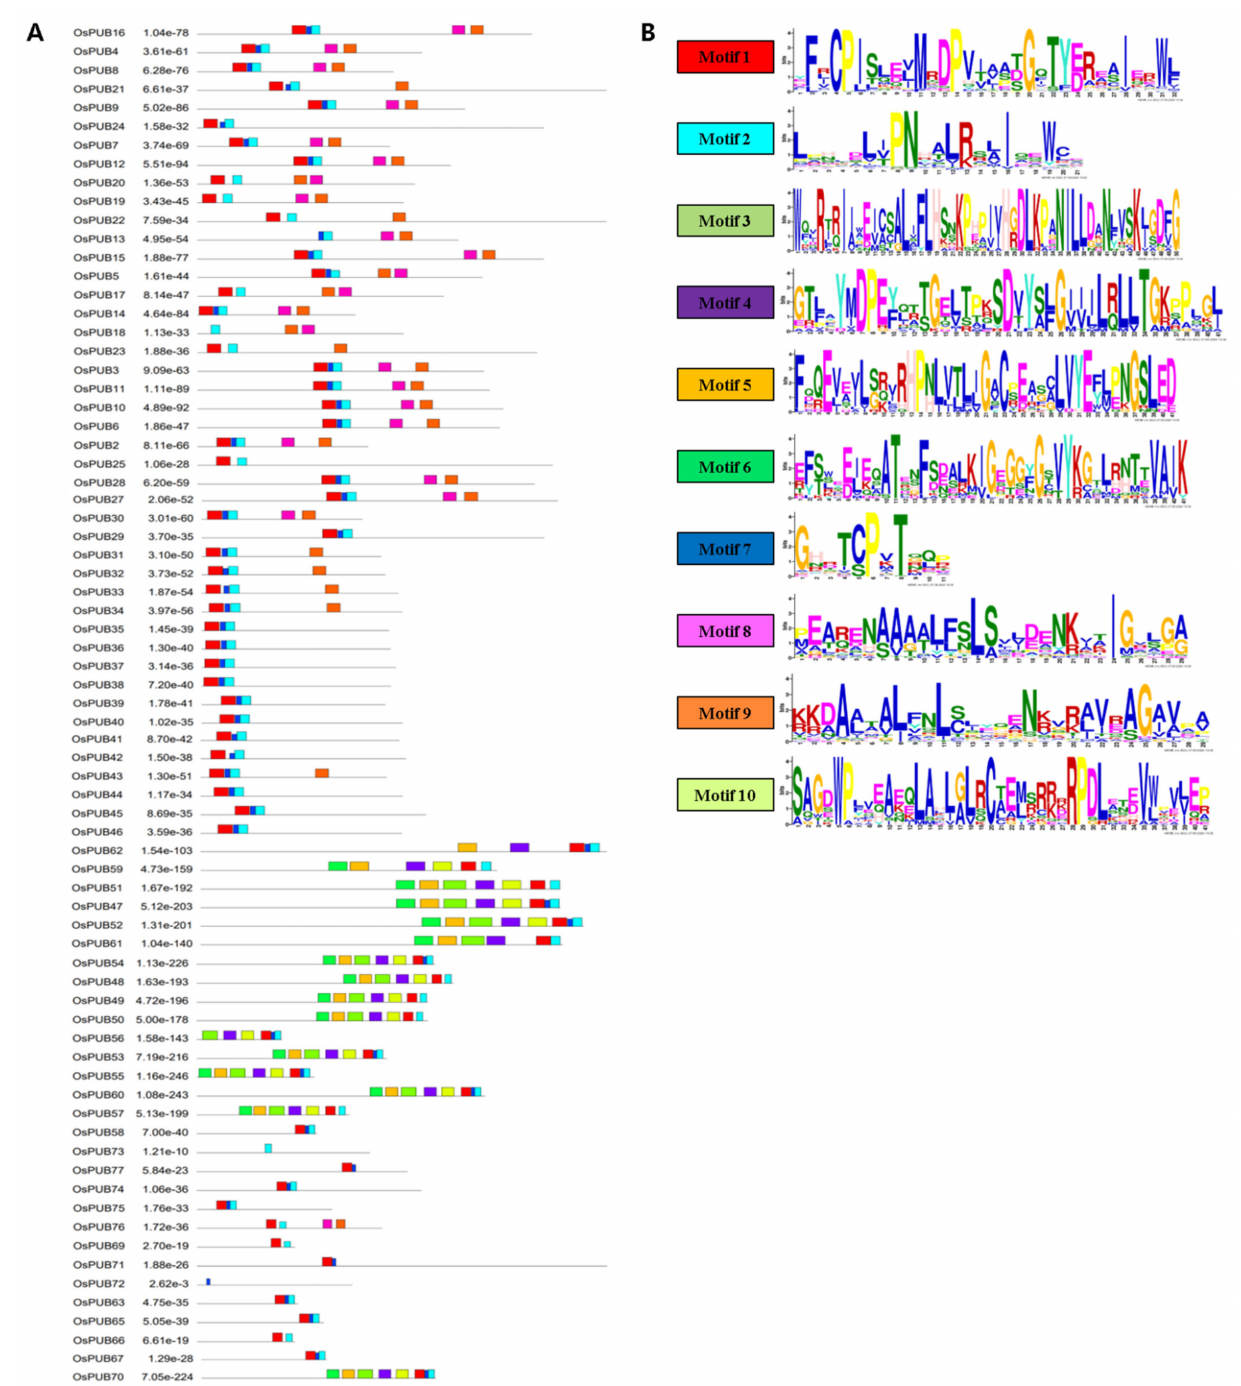
Figure 4. Gene structure and conserved protein sequence patterns of OsPUB gene family. ( A ) Conserved motifs in OsPUB genes. These motifs were identified with the MEME program. Ten conserved motifs are displayed with different colored boxes. ( B ) Sequence logos of 10 conserved motifs. The height of the letter showing amino acid residue at each position represents the degree of conservation. Numbers on the x -axis represent residue positions in motifs. The y -axis represents content measured in